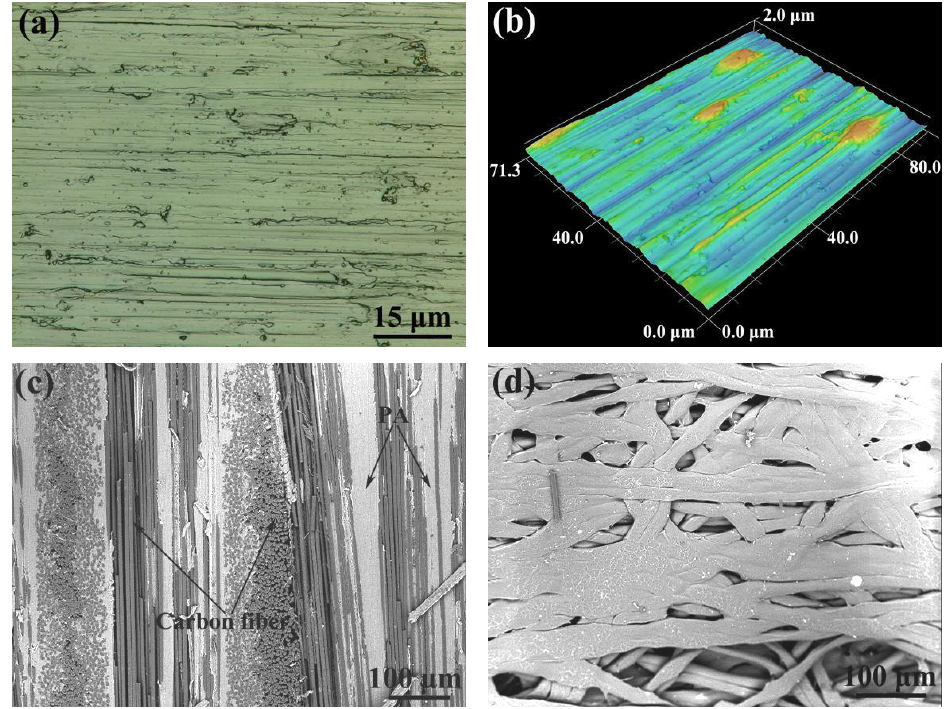
Figure 4. ( a ) Optical microscopy image of the untreated Al alloy, ( b ) surface morphology of the untreated Al alloy, ( c ) microstructure of the CFRTP, and ( d ) microstructure of the polyamide (PA) additive.